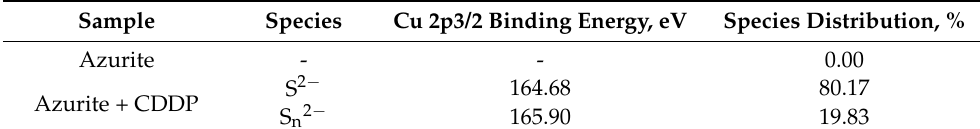
Table 4. S2p quantification of azurite and CDDP-treated azurite.